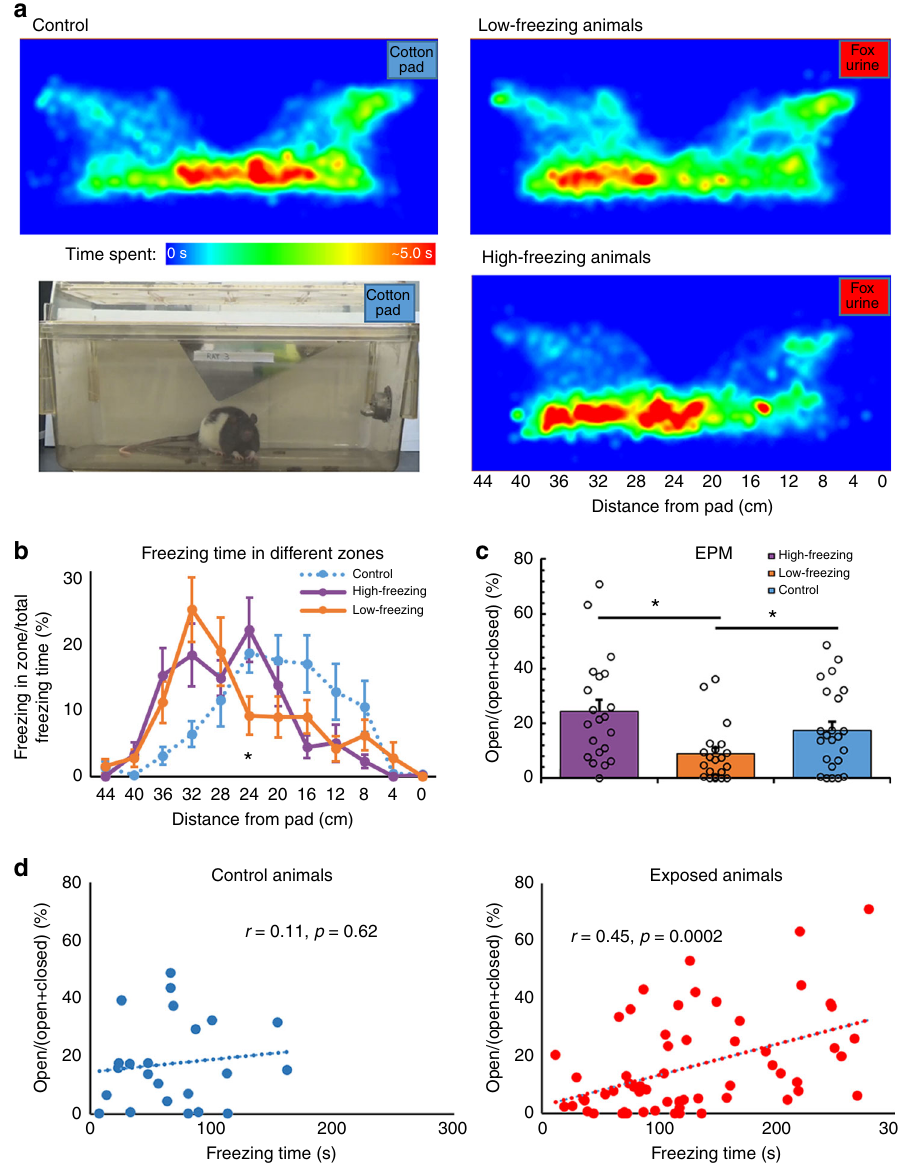
Fig. 2 Stronger stress response and higher long-lasing anxiety in low-freezing animals. a Heat maps of the total time at each location for the control, low- freezing, and high-freezing groups. The control group showed no evident bias for either side of the cage. The low-freezing group showed a strong bias toward the far end (from the pad) of the cage, while the high-freezing rats also showed a bias toward the far end of the cage, but to a lesser extent. b The distribution of the percent freezing time for each group across the cage, divided into 12 equivalent-sized zones. The x -axis indicates the distance to the pad from the center of each zone. Similar to the distributions of total time spent, the percent freezing time in control rats displayed little bias for either side of the cage. High- and low-freezing animals showed a bias of percent freezing time toward the far end of the cage, with the low-freezing rats showing even stronger bias than high-freezing animals, evidenced by signi fi cantly lower percent freezing time of the low-freezing group in the zone 24 cm away from the pad compared to the high-freezing group ( p = 0.04). c Elevated plus maze performed 6 days post exposure in all three groups of animals. Low-freezing animals showed a signi fi cantly lower EPM score (open/open + closed arm time) compared to both control ( p = 0.030) and high-freezing animals ( p = 0.0017), while no signi fi cant difference was seen between control and high-freezing groups. d The freezing time was positively correlated to the EPM score across all exposed animals ( r = 0.45, p = 0.0002), but not across control animals ( r = 0.11, p = 0.62). Bars indicate s.e.m. Source data of Fig. 2b – d are provided as a Source Data fi To assess the long-lasting PTSD-like behaviors in exposed arm time in EPM tests (Fig. 2c). There was no statistical animals, we measured anxiety levels using an elevated plus maze difference between high-freezing and control animals, indicating (EPM) 6 days after predator scent exposure. Resembling the that low-, but not high-freezing animals were susceptible to observation of increased avoidance, low-freezing animals exhib- developing PTSD-like behaviors following exposure to predator ited heightened long-lasting anxiety compared to both control ( t - scent. In addition, freezing was positively correlated with the test, t = 2.24, p = 0.030) and high-freezing animals ( t -test, t = EPM score in exposed animals ( R 2 = 0.21, p = 0.0002), but not controls ( R 2 = 0.01, p = 0.62, Fig. 2d). These results demonstrate 3.37, p = 0.0017), as indicated by the ratio of open/open + close